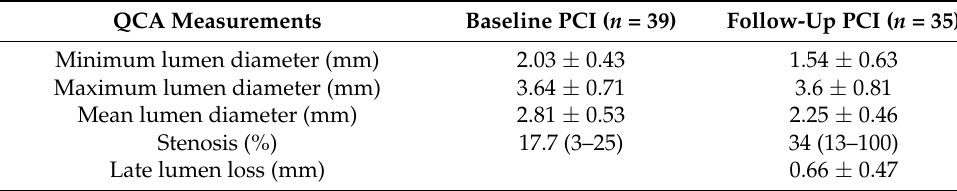
Table 2. Quantitative coronary angiography analysis.